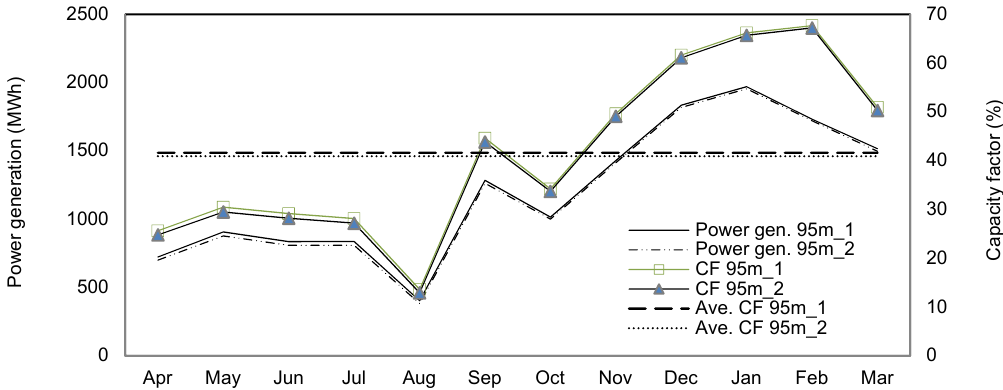
Figure 7. Power generation and capacity factor of a 4-MW Siemens SWT-4.0-120 turbine from April 2016 to April 2017 at mast site estimated using two sets of measured data at mast height of 95 m.